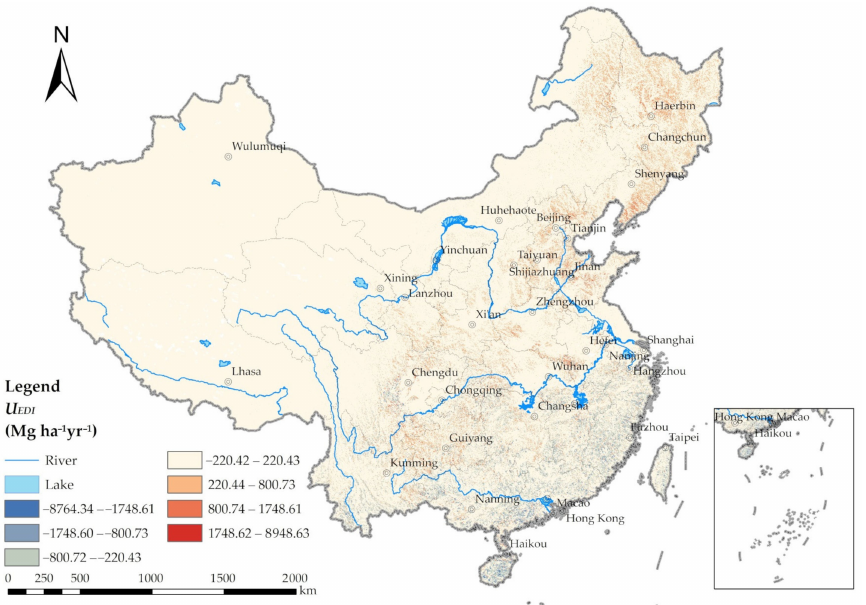
Figure 4. U EDI value of soil erosion as the deviation between the soil erosion estimated in this study and the traditional RUSLE.